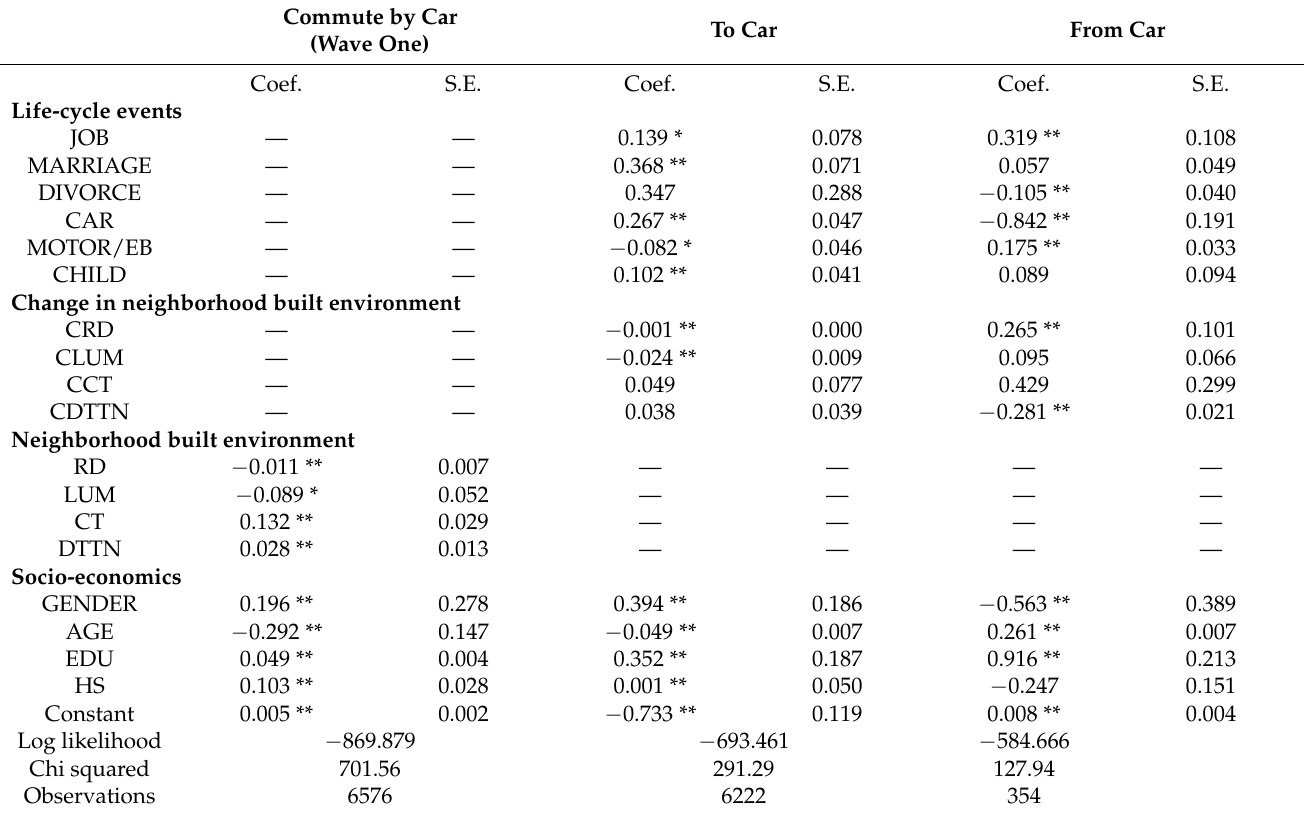
Table 3. Logistic models of car commuting and switches to and from this position. Commute by Car To Car From Car (Wave One) Coef. Coef.